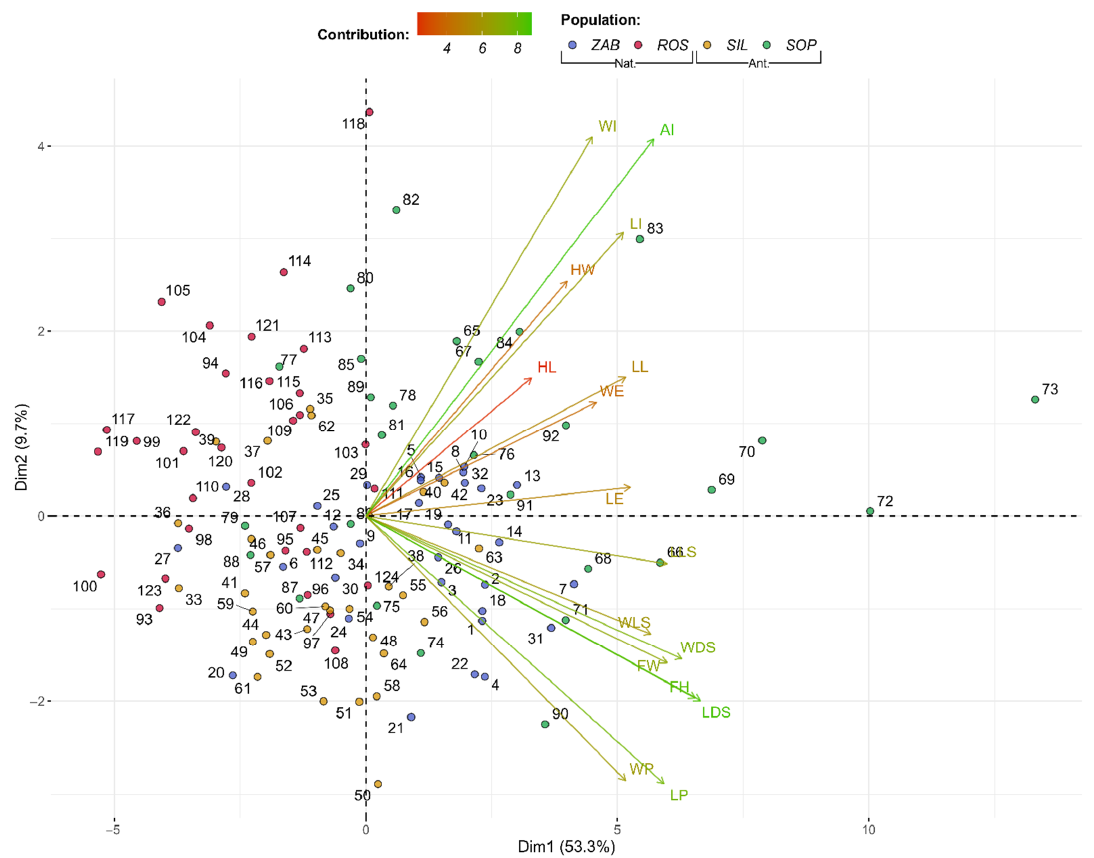
Figure 1. Biplot of flower structure profiles for Epipactis palustris natural (Nat.) and anthropogenic (Ant.) populations, showing the first two dimensions or factors (Dim1-2) of PCA that, together, explain 63% of the variance. Biplot vectors indicate the strength and direction of factor loading for the first two factors. Individuals (populations) are color-coded by